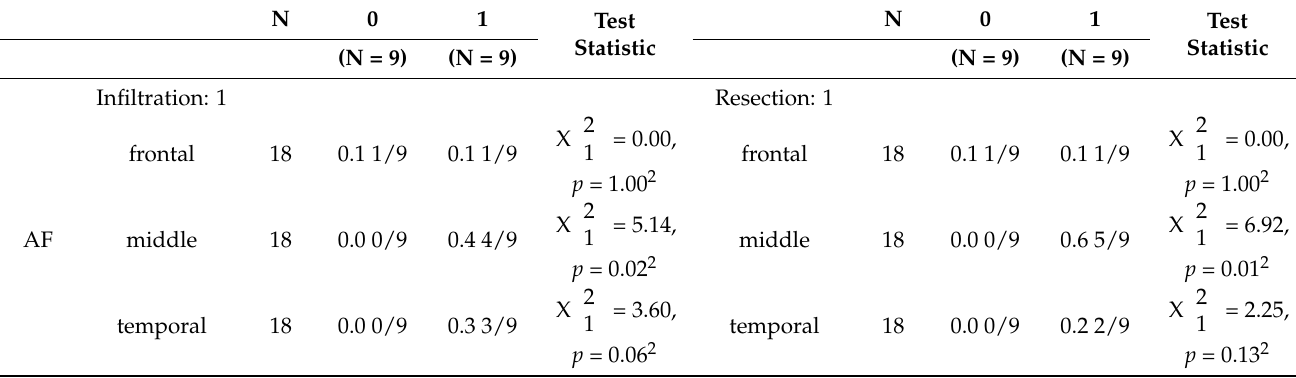
Table 4. Statistical analysis for postoperative persistent aphasia in perisylvian left-hemisphere glioma. N is the number of non-missing value. 1, Kruskal-Wallis. 2,